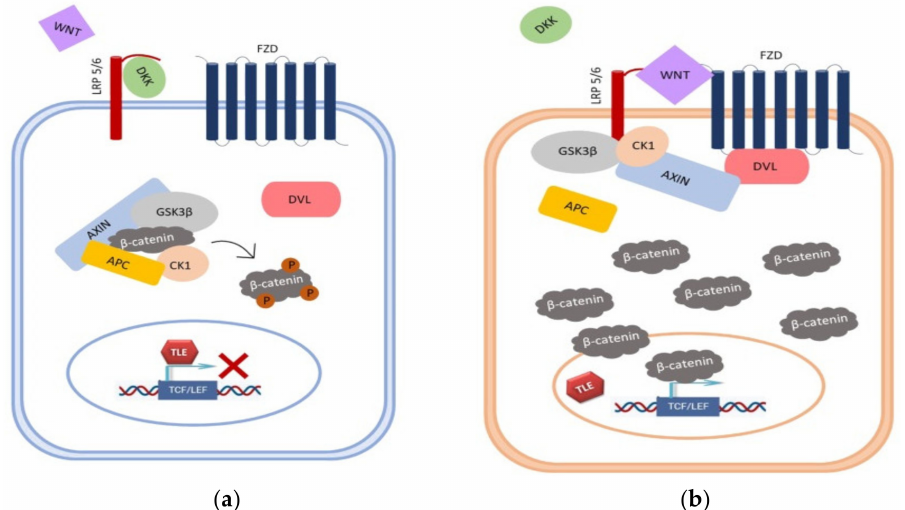
Figure 1. Overview of Wnt signaling pathway. ( a ) In the canonical Wnt pathway, DKK directly competes with Wnt for binding to LRP6. When DKK binds to the receptor, cytosolic pool of β -catenin is maintained at low levels through proteasomal degradation, due to its phosphorylation by the complex consisting of Axin/APC/CK1/GSK-3 β . ( b ) Binding of Wnt to receptors Fz/LRP leads to the recruitment of components of the destruction complex to the membrane. This prevents phosphorylation and degradation of β -catenin, resulting in its accumulation in the cytoplasm. Stabilized β -catenin translocates into the nucleus and activates transcription of Wnt target